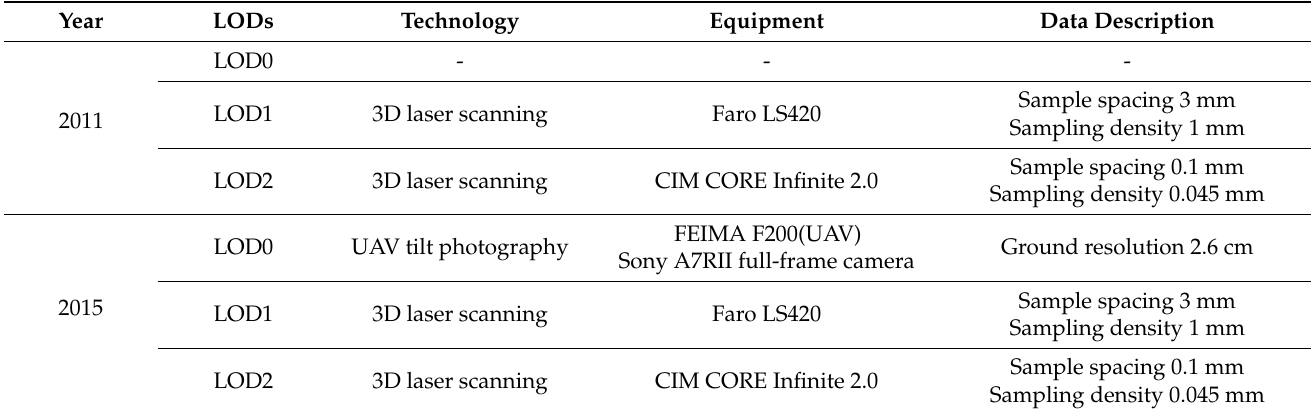
Table 1. Details of data collection.